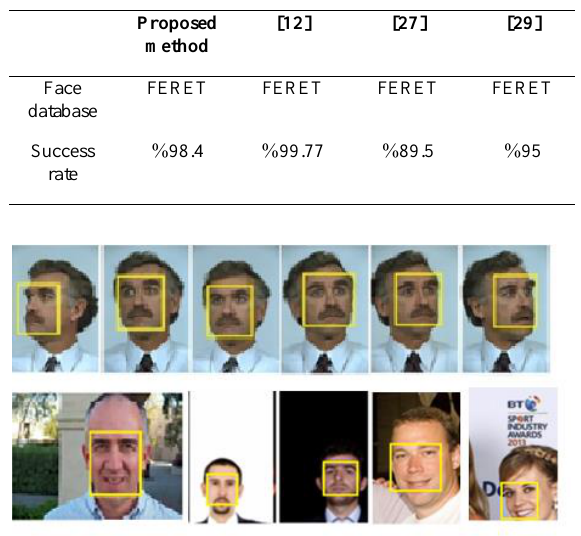
Figure 7. The results of the proposed face detection algorithm on some image